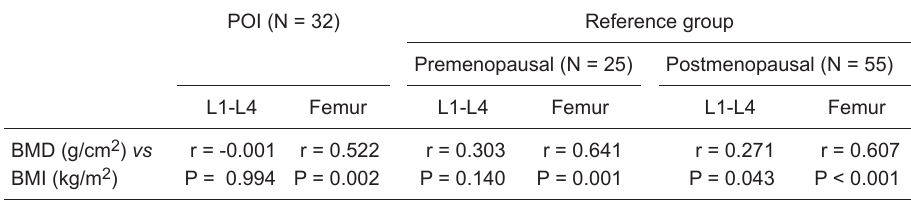
Table 3. Correlations between lumbar (L1-L4) and femoral bone mineral density and body mass index in the primary ovarian insufficiency and reference